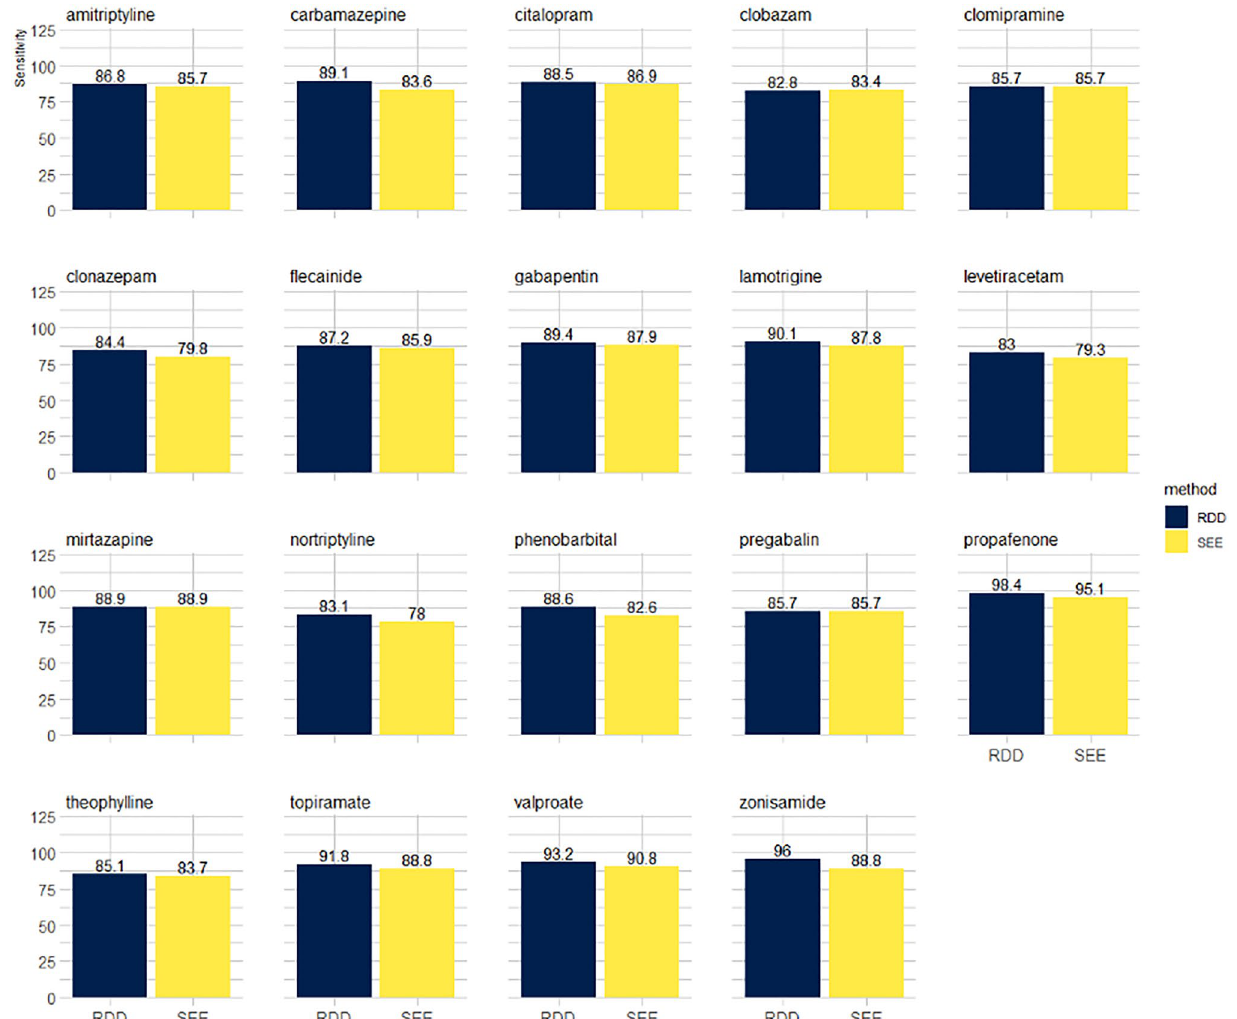
Figure 4. Comparison of the performances (sensitivity) of the Sessa Empirical Estimator (SEE) with the Research-Defined Duration